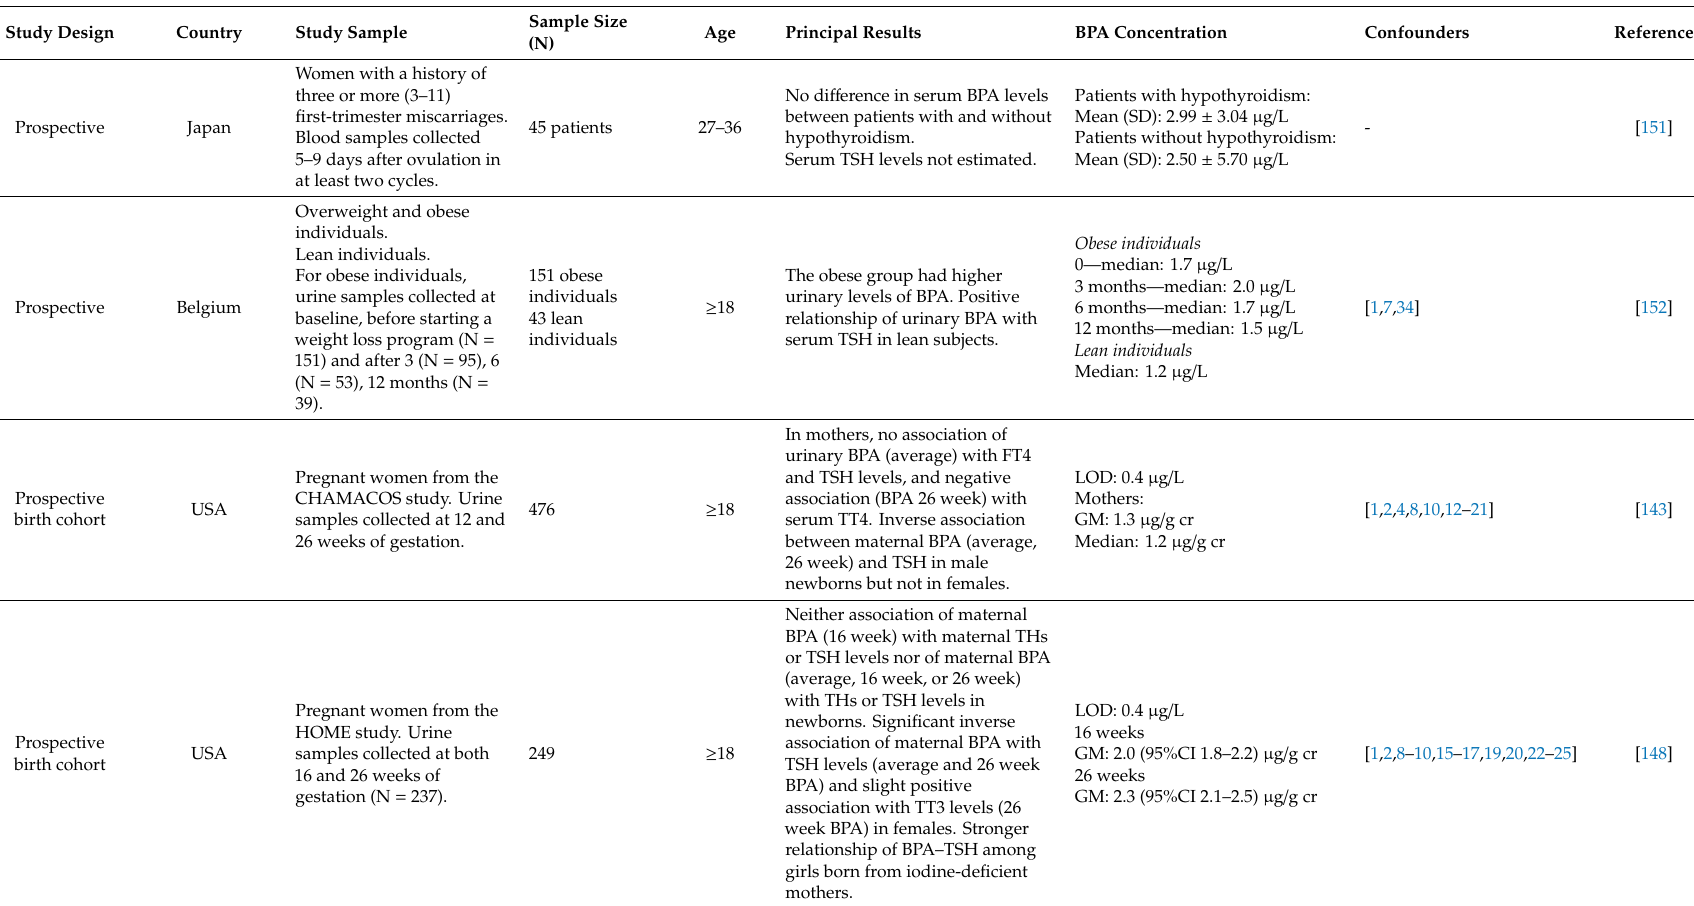
Table 4. Summary of human studies on the association between bisphenols exposure and thyroid